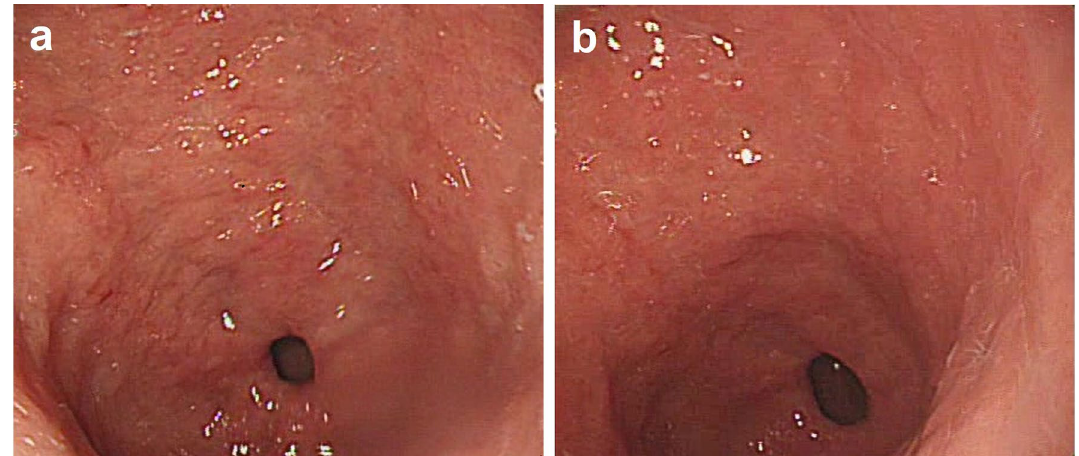
Figure 5. The representative endoscopic images before ( a ) and 1 min after spraying l-menthol ( b ).